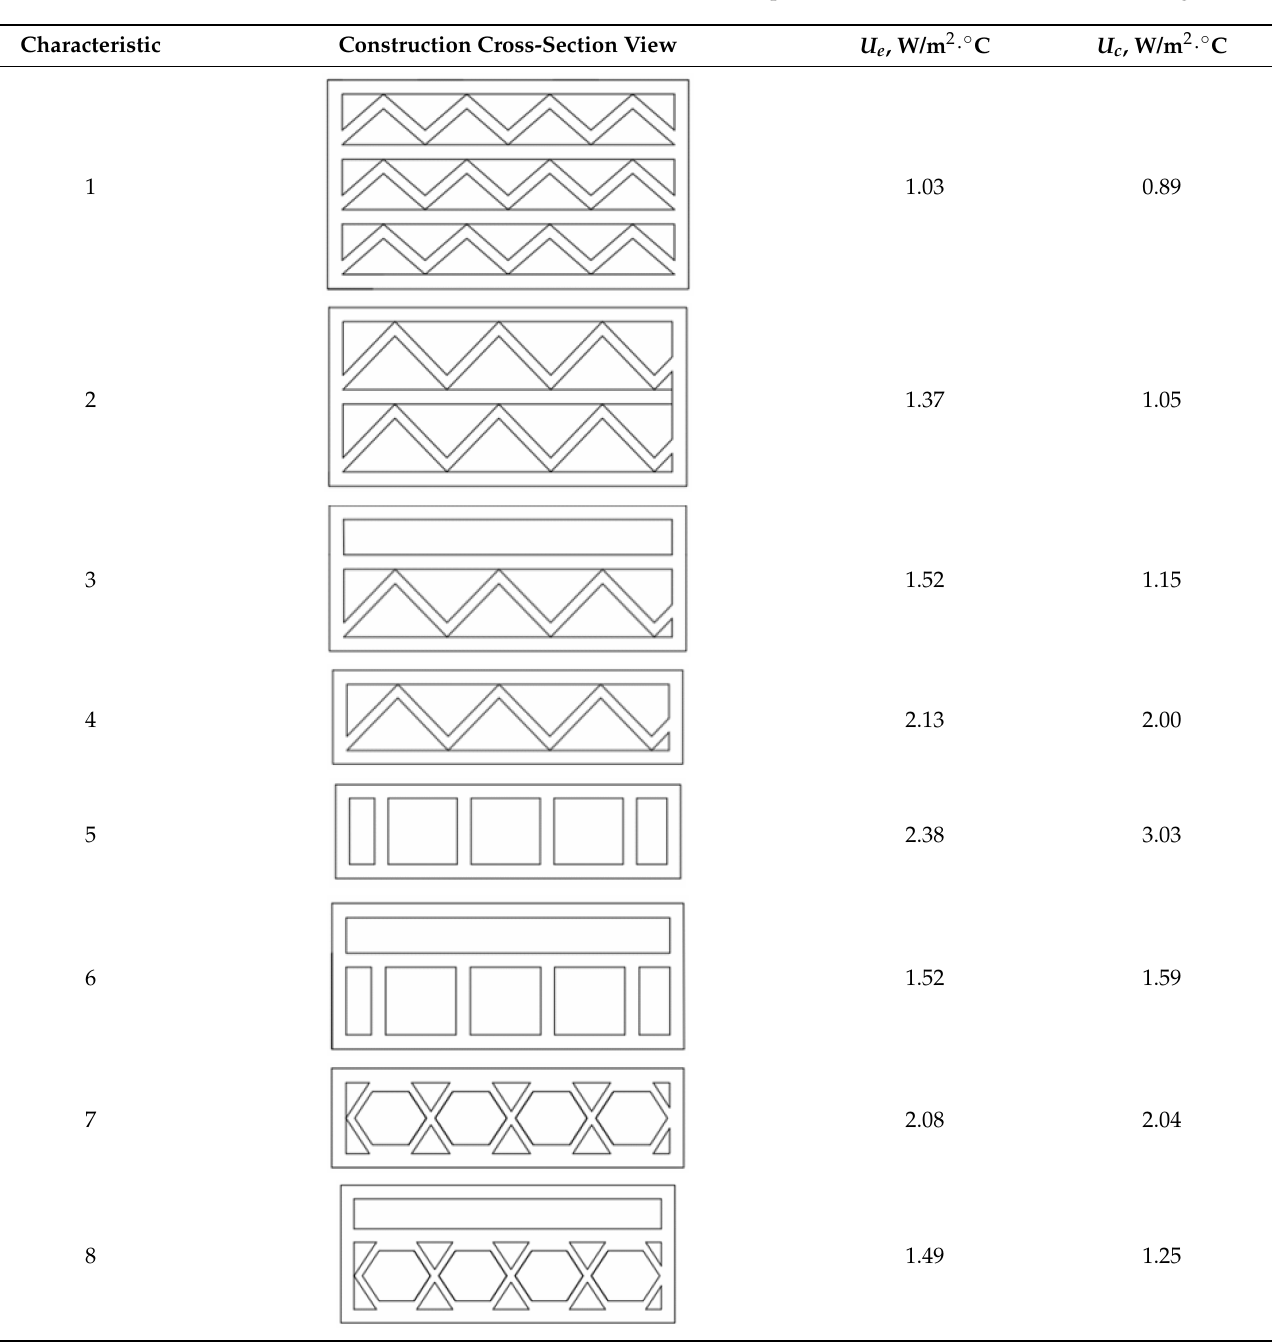
Table 7. Thermal transmittance U-values of 3D-printed constructions with different